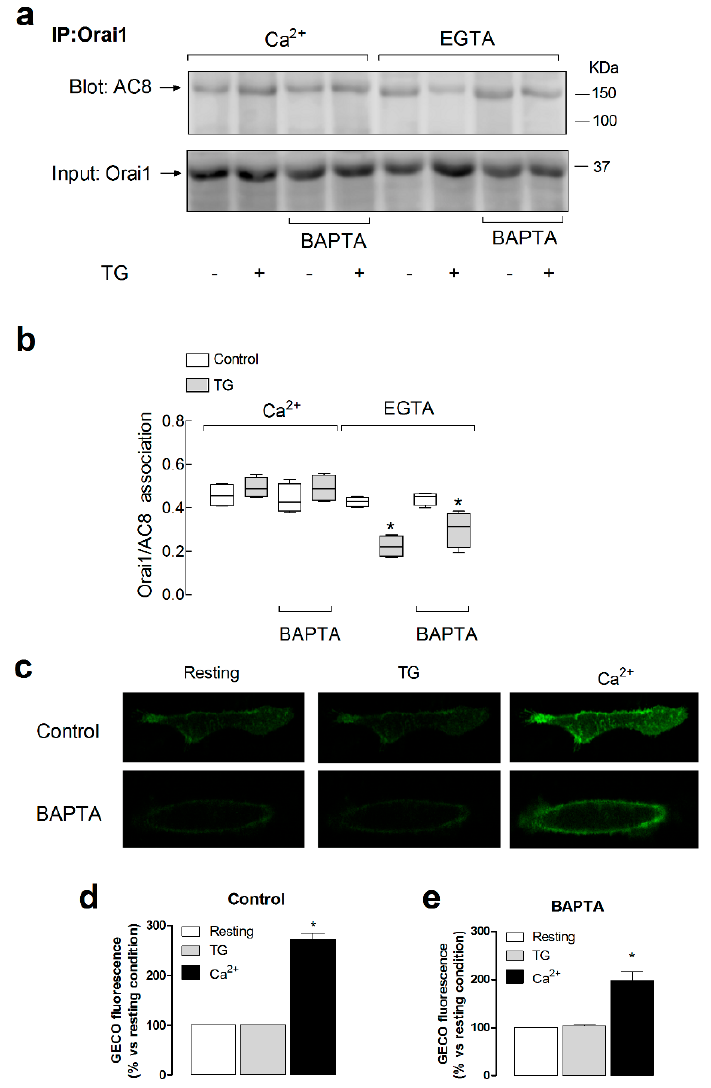
Figure 2. Role of Ca 2+ mobilization in the Orai1–AC8 interaction. ( a ) MDA-MB-231 cells were loaded with dimethyl BAPTA or left untreated, as indicated, and then suspended in a medium containing 1 mM Ca 2+ or in a Ca 2+ -free medium (100 µM EGTA added). Cells were treated with 1 µM TG or the vehicle, as indicated, and lysed 1 min later. Whole-cell lysates were immunoprecipitated (IP) with the anti-Orai1 antibody. Immunoprecipitates were subjected to 10% SDS-PAGE and subsequent Western blotting with specific anti-AC8 antibody, as indicated. Membranes were reprobed with the antibody used for immunoprecipitation for protein loading control. The panels show results from one experiment representative of five others. Molecular masses indicated on the right were determined using molecular-mass markers run in the same gel. ( b ) The box plot represents the quantification of AC8–Orai1 interaction in resting and TG-treated cells. Results are normalized to the Orai1 expression; * p < 0.05 compared to the corresponding control (untreated cells). ( c ) Cells were transfected with G-GECO1.2-Orai1. Forty-eight hours later, cells were suspended in a Ca 2+ -free medium and stimulated with TG (1 µM) for 2 min, followed by addition of CaCl 2 (final concentration 1 mM) to the medium to initiate Ca 2+ entry. Images are representative of six independent experiments. ( d – e ) Bar graphs represent the quantification of the G-GECO (green genetically encoded Ca 2+ indicator for optical imaging) fluorescence in cells loaded with dimethyl BAPTA (BAPTA) or left untreated (control), as indicated. Fluorescence was analyzed at rest, 30 s after the addition of 1 µM TG and 30 s after the subsequent addition of CaCl 2 (final concentration 1 mM).